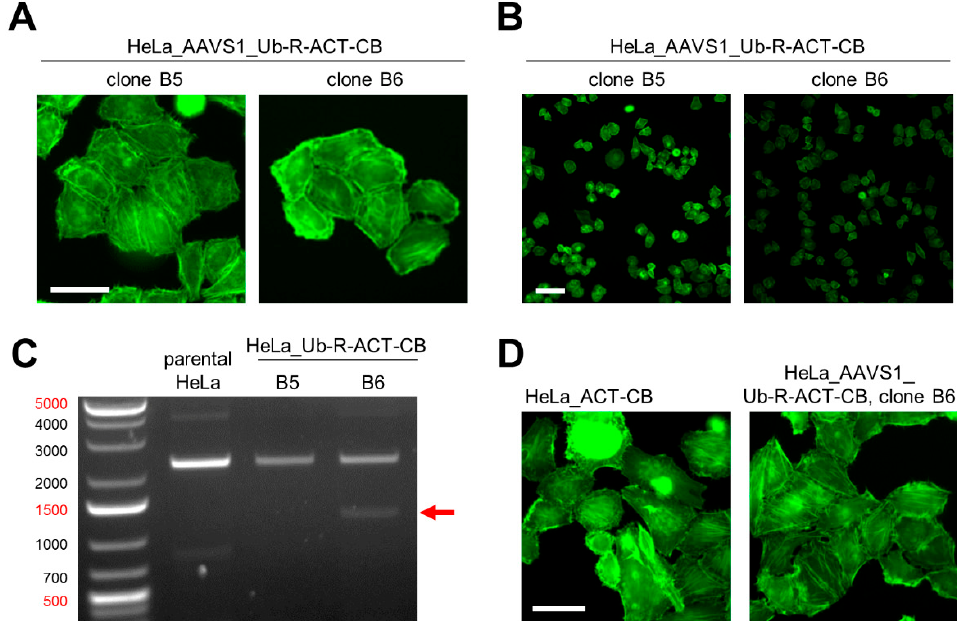
Figure 5. Generation of a HeLa cell line expressing Ub-R-ACT-CB stably integrated into the AAVS1 locus by using CRISPR/Cas9 technology. ( A ) Fluorescence images of two CRISPR-engineered HeLa cell clones expressing ACT-CB, scale bar: 50 µM. ( B ) Comparison of fluorescence intensity between HeLa_AAVS1_Ub-R-ACT-CB clone B5 and B6, scale bar: 100 µm. ( C ) PCR-based genotyping of HeLa_AAVS1_Ub-R-BC1-CB clones B5 and B6 in comparison to parental HeLa cells. Genomic DNA of the monoclonal cells was extracted and subjected to PCR using the genotyping strategy illustrated in Figure 4B. Shown are the resulting PCR products (indicated by arrow) on a 1% agarose gel stained with ethidiumbromid. ( D ) Representative fluorescence images of living HeLa cells stably expressing the respective ACT-CB. Left image illustrates HeLa_ACT-CB cells generated by random integration of the non-modified ACT-CB. The right image shows HeLa_AAVS1_Ub-R-ACT-CB cells generated by site-directed integration of the ubiquitin-modified ACT-CB using CRISPR/Cas9 technology, scale bar: 50 µm.